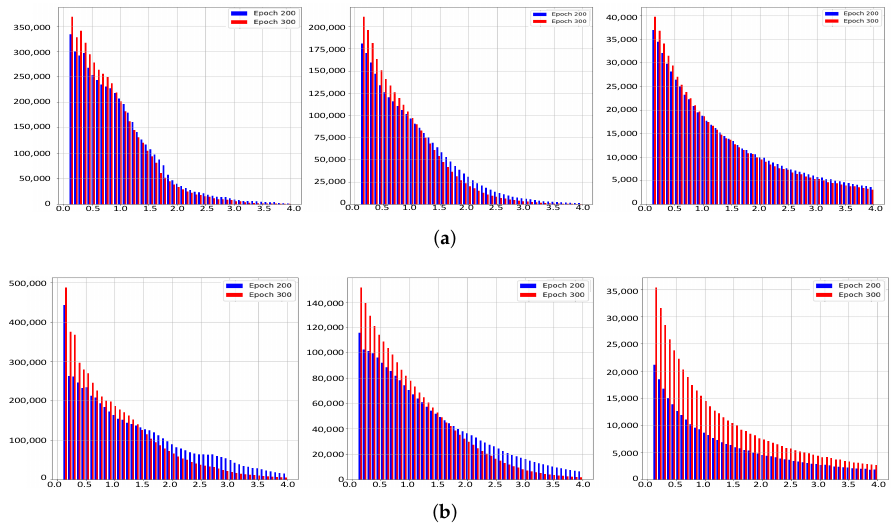
Figure 2. The activation values changing of a network ResNet-110 trained for 300 epochs. The blue column indicates activation values of the network ResNet-110 obtained at the 200th epoch, and the red column indicates activation values of the network ResNet-110 obtained at the 300th epoch. ( a ) Baseline. ( b )